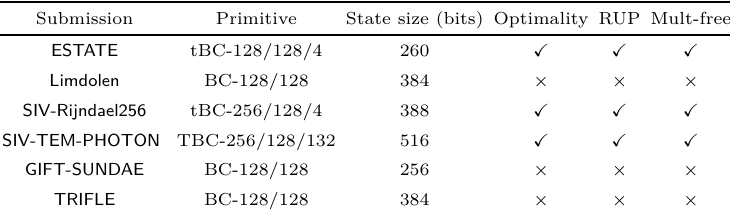
Table 1: Comparative Study on SIV based NIST candidates with ESTATE . A block cipher with block size of n bits and key size of κ bits is denoted as BC- n/κ and a tweakable block cipher with n bit block, κ bit key and τ bit tweak is denoted as TBC- n/κ/τ (tBC- n/κ/τ for short tweaks). Note that the field ’Optimality’ denotes the optimality on the number of primitive